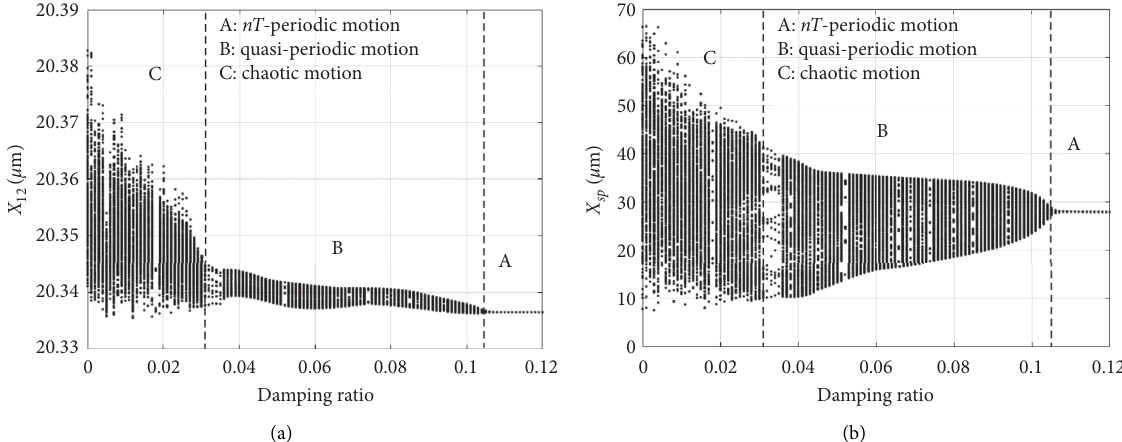
Figure 11: Bifurcation diagram of system with varying damping ratio of gear meshing pair. (a) Relative displacement of spline joint pair, (b) relative displacement of external gear meshing pair.